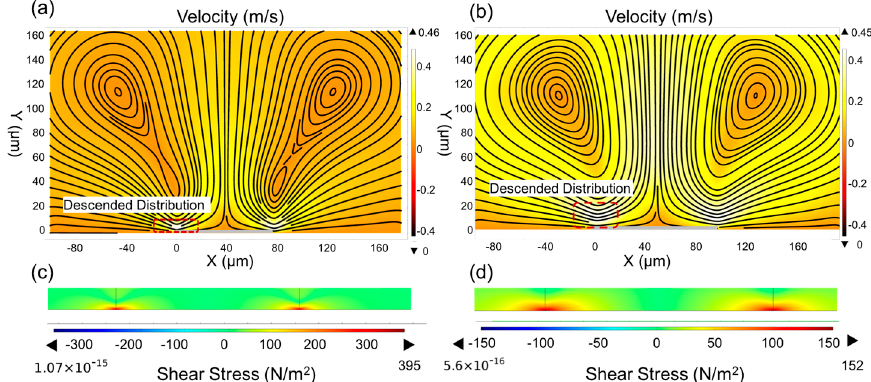
Figure 1. Simulated results of the 2D FEM analysis. Micro-vortices are formed under the resonator stimulation of ( a ) 1.5 GHz and ( b ) 750 MHz. The simulated shear stress induced by the flow with the excitation frequency of ( c ) 1.5 GHz and ( d ) 750 MHz.